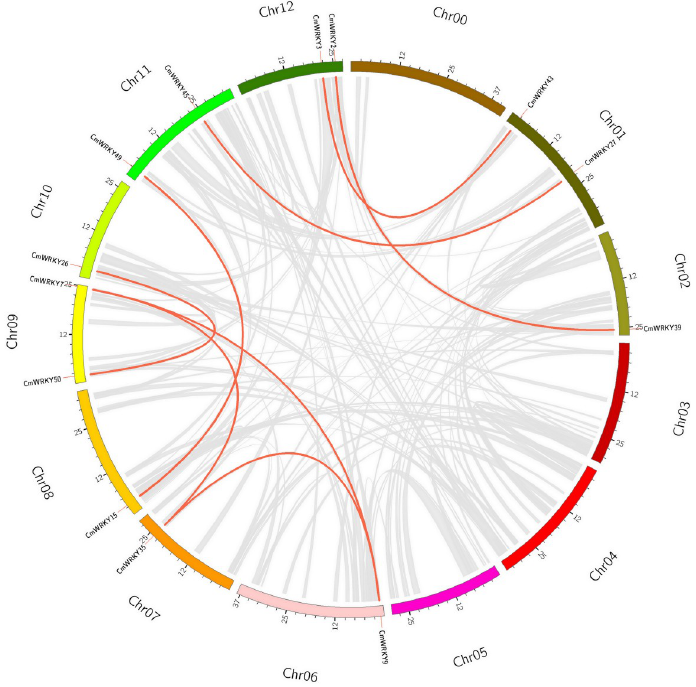
Fig 3. Synteny analysis of melon genome and segmental duplications of CmWRKY s. Gray curves denote the details of syntenic regions in melon genome and red curves denote CmWRKY gene pairs with segmental